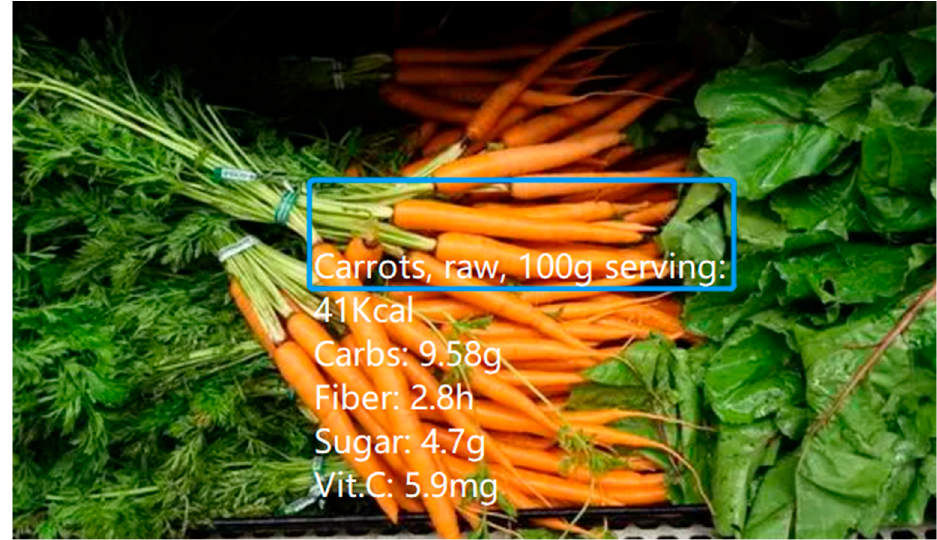
Figure 3. The nutritional information on a tracked grocery item. The blue box represents the location of the food as tracked by the proposed system. Information for several nutrients is reported per 100 g. Reproduced from Jiang et al. [8].